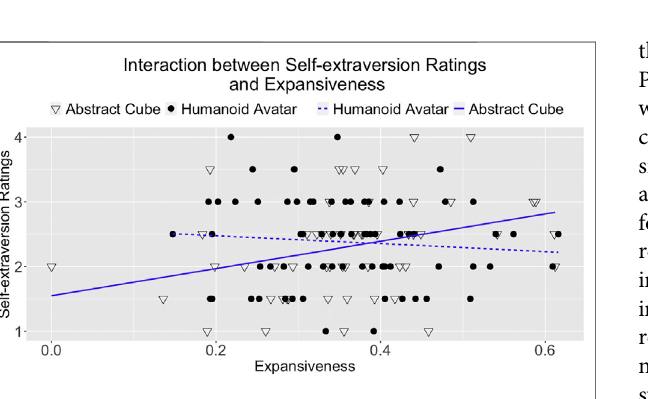
FIGURE 4 | Interaction between self-extraversion ratings and